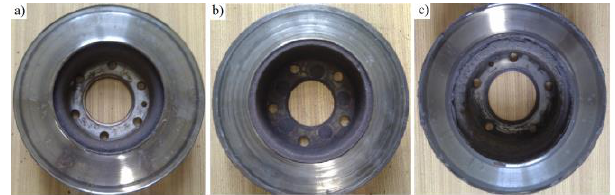
Fig. 10. Macroscopic images of comparative brake discs: a) numerous gouges occurring circumferentially on both friction surfaces, whose darker color indicates overheating; b) wear of the disc manifested by a decrease in thickness; c) wear of the disc due to corrosion changes